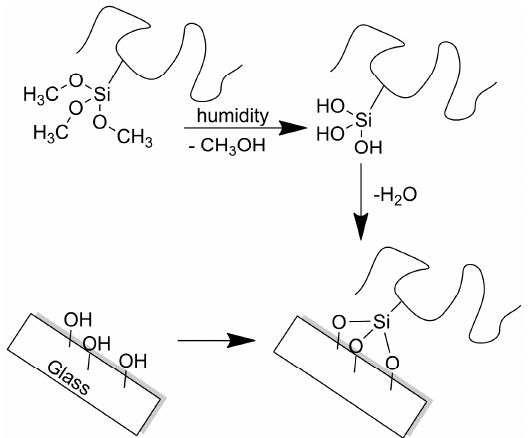
Figure 5. Schematic of the chemical functionalization of the glass slides with the zwitterionic and fluorinated copolymers containing PTMSi counits through a “grafting-to” approach.